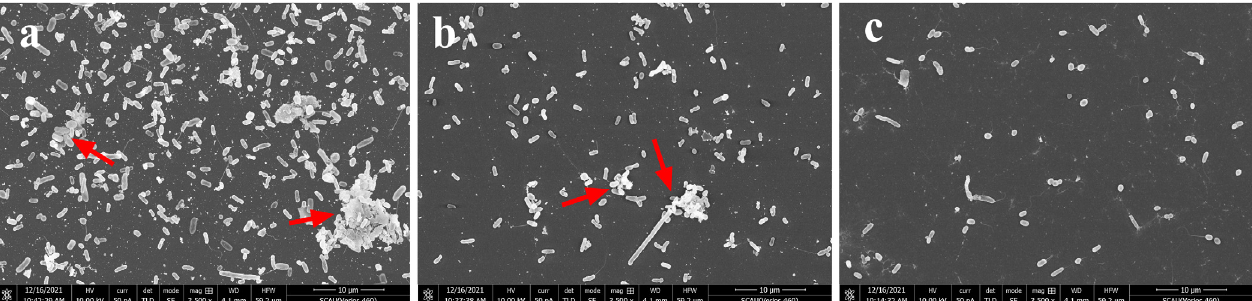
Figure 7. The effects of Z057-E on the structures of V. parahaemolyticus biofilms as observed by scanning electron microscope. ( a – c ) represented the structures of biofilms treated with 0, 0.8, and 1.6 mg/mL of Z057-E, respectively. The red arrows pointed to the aggregated